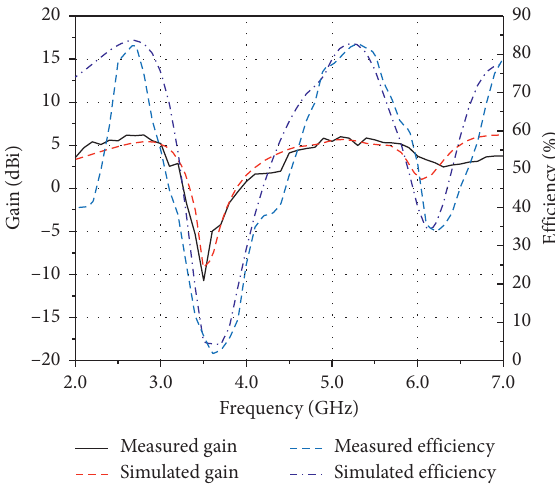
Figure 8: Simulated and measured gain and efficiency.